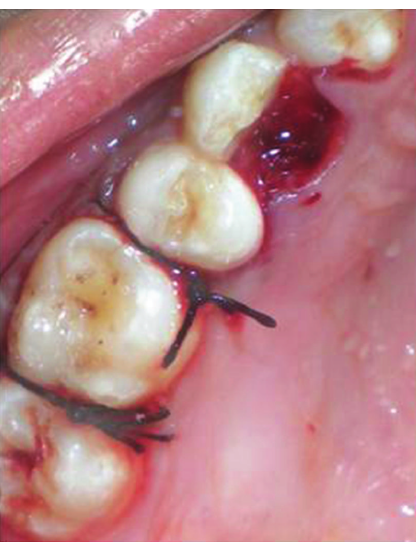
Figure 19: Occlusal view of 16 after application of dead soft matrix band for accurate positioning of distofacial cusp and restoration of the lost mesiopalatal cusp with restorative resin.